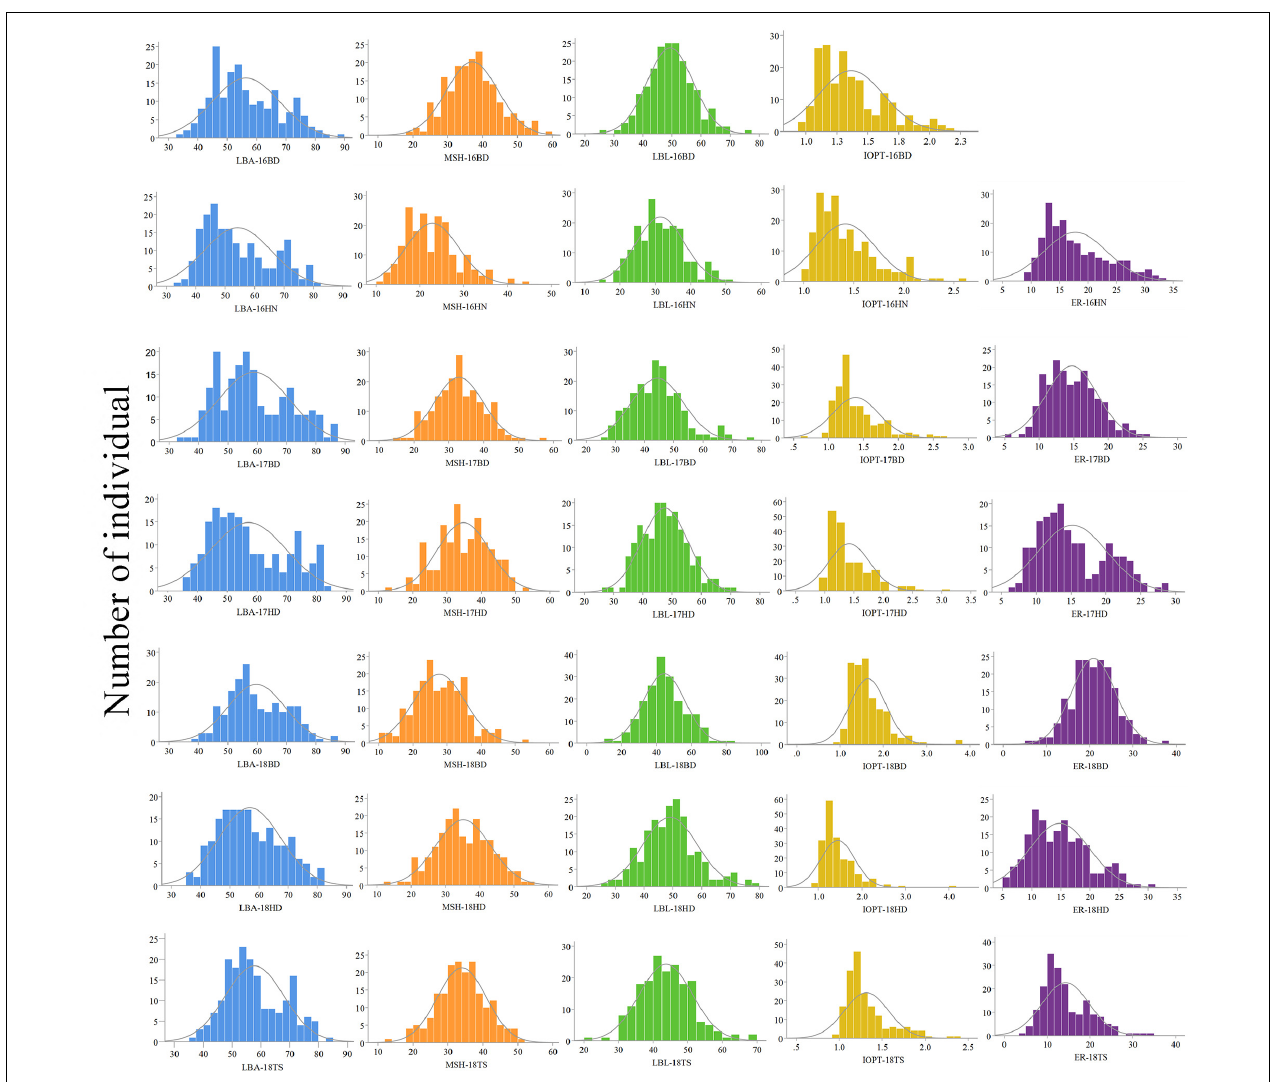
FIGURE 2 | Phenotypic distributions of growth habit-related traits in the RIL population under seven